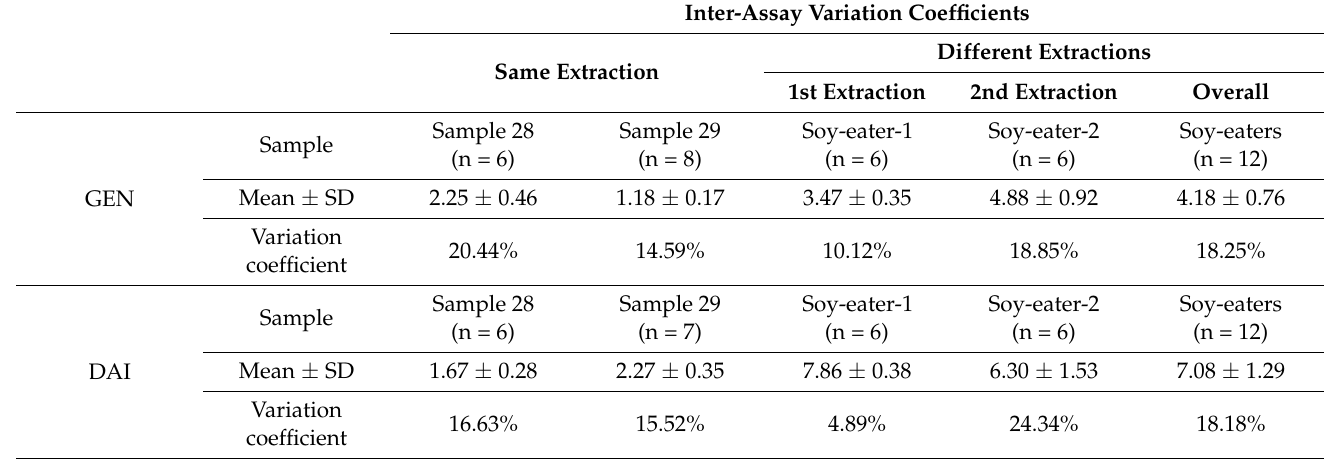
Table 3. Repeatability and reliability tests of the GEN and DAI